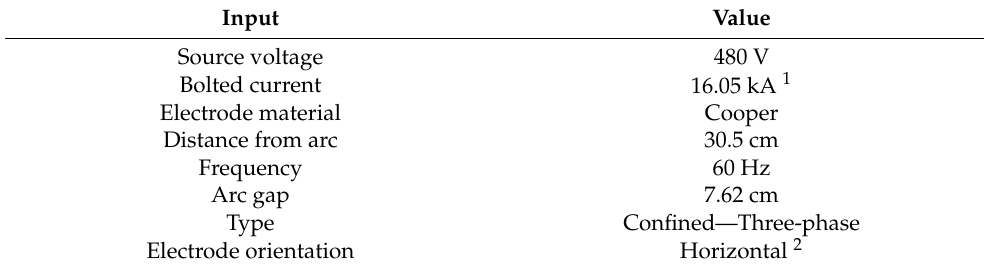
Figure 11. Data input screen for ArcPro simulation—Case study 4. Table 8. Relation of input data for ArcPro simulation—Case study 4. Table 8. Relation of input data for ArcPro simulation—Case study 4.